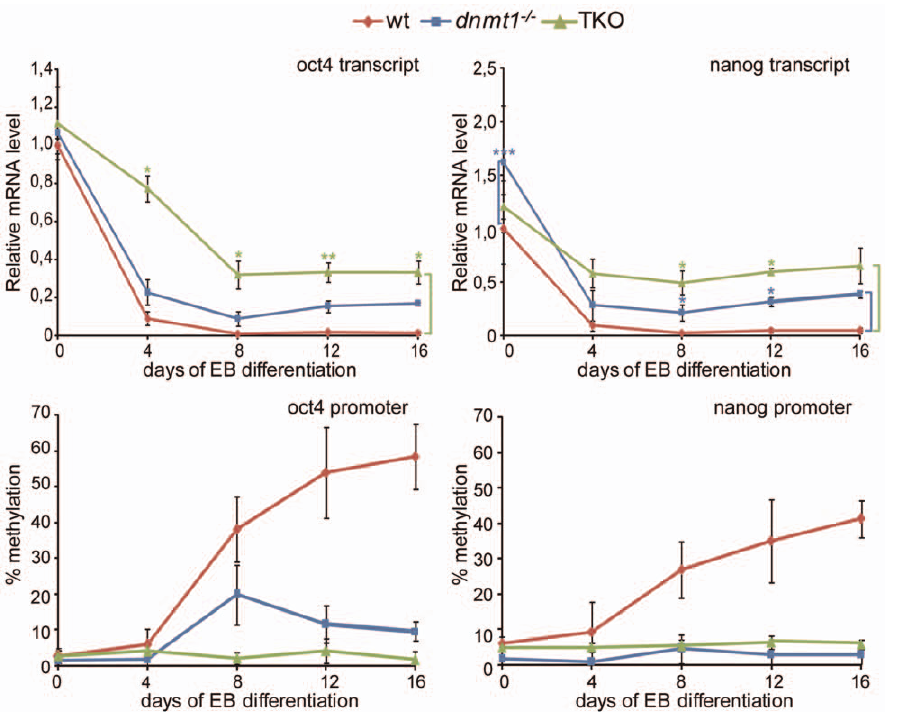
Figure 1. Partial silencing of oct4 and nanog in Dnmt1 2 / 2 and TKO EBs. Oct4 and Nanog transcript levels (upper panels) and respective promoter methylation (lower panels) during differentiation of wt, Dnmt1 2 / 2 and TKO ESCs as EBs. Transcript levels were measured by RT-qPCR and are shown relative to wt ESCs (day 0). DNA methylation levels were determined by bisulfite conversion followed by PCR and pyrosequencing. Five and 4 CpG sites in the proximal promoter regions of oct4 and nanog , respectively, were analyzed and respective values were averaged. Mean values and standard errors of 2 and 3 biological replicates are shown for DNA methylation and expression analyses, respectively. Asterisks indicate significance levels: * p , 0.05; ** p , 0.001; *** p , 0.0001 (Student t-test).